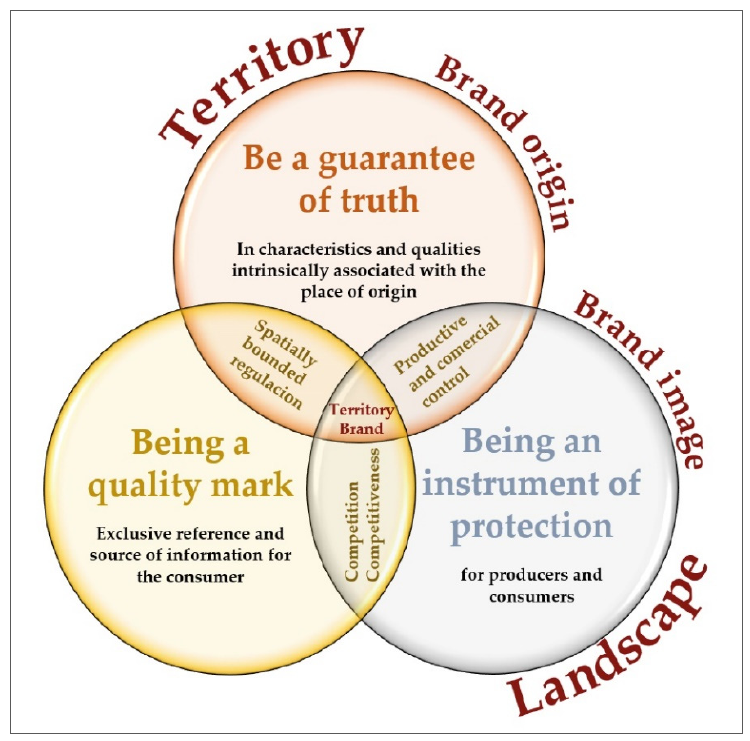
Figure 1. Functions of territorial food indication. Source: Own elaboration.